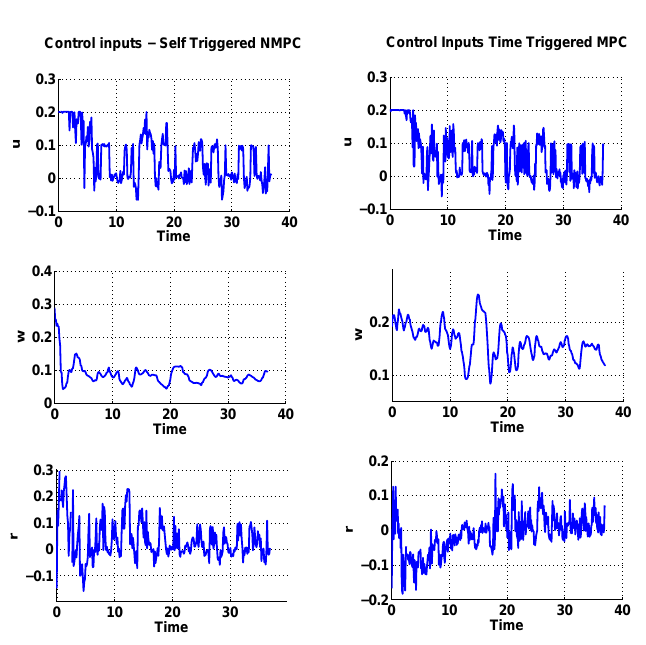
Figure 10. Control inputs. ( Left ) Proposed self-Triggered N-MPC. ( Right ) Classic N-MPC, c (cid:13) 2014 IEEE